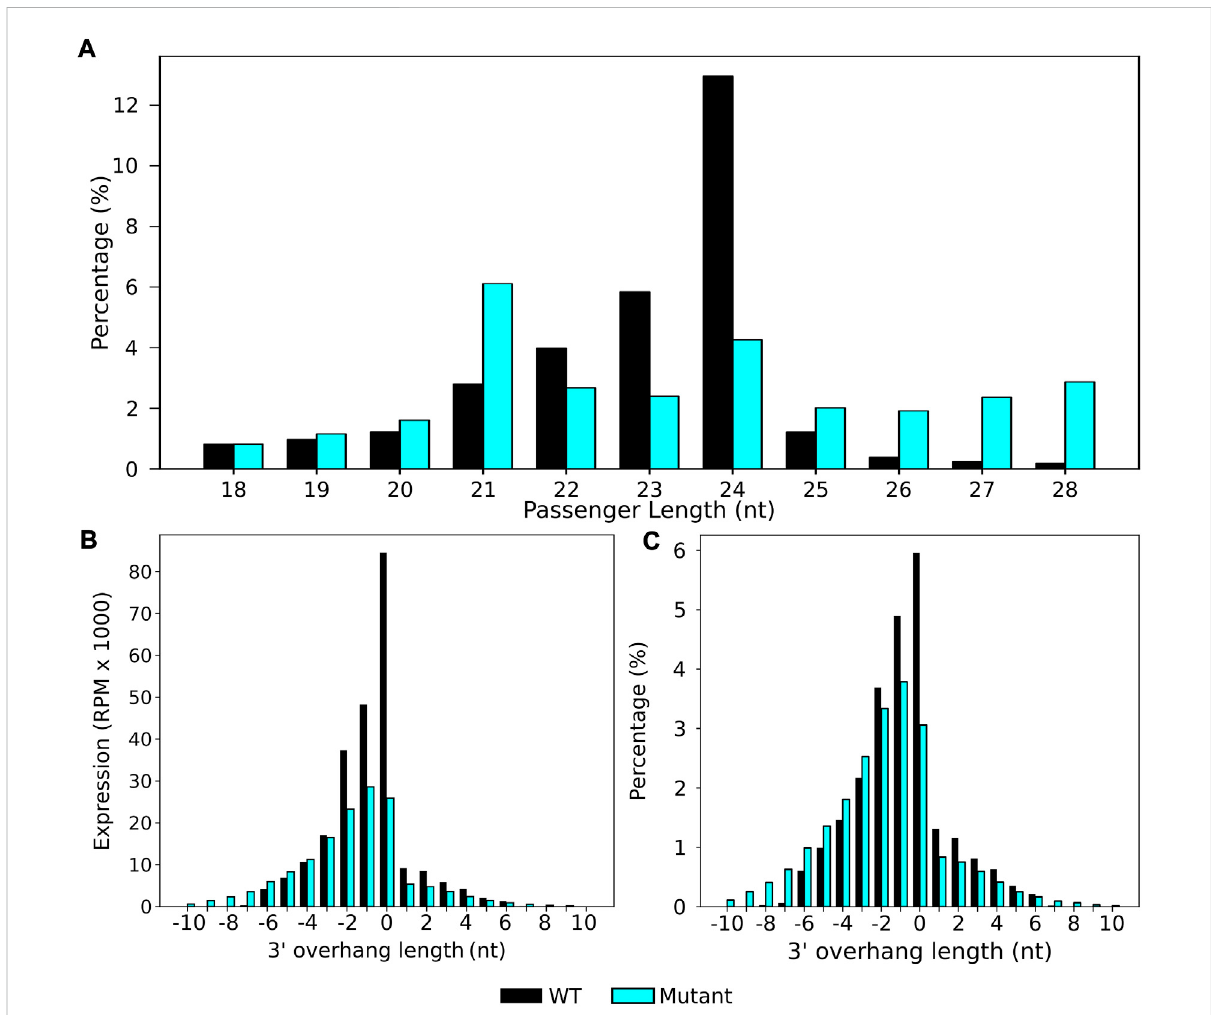
FIGURE 4 Dicer cleavage signatures for 24 nt siRNAs were uncovered in a wild-type A. thaliana sRNA raw data by stepRNA. stepRNA was fi rst run using a collapsed fi leofreferencesRNAsreads i.e. thatonlycontaineduniquesequences,asboththereferenceandqueryinput,fromawild-type(black)and dcl2dcl3dcl4 mutant (blue) A. thaliana sRNA library. (A) Bar graphs show the length distribution of sRNA sequences predicted to have a passenger strand n. b. the data includes both the predicted sRNA and its passenger strand because these cannot be distinguished at this stage. stepRNA output for both wild-type and dcl2dcl3dcl4 mutant strains are shown, identifying that 24 nt sRNAs are most likely to have a passenger strand in wild type but not dcl2dcl3dcl4 mutant. (B) Bar graph showing the expression of sRNA in duplexes and the 3 ′ overhang length in the predicted sRNA duplex. (C) Bar graph showing the percentage of sRNA duplexes with at least one overhang of the corresponding length at the 3 ′ end (n = 2908404 WT, n = 2733702 dcl2dcl3dcl4